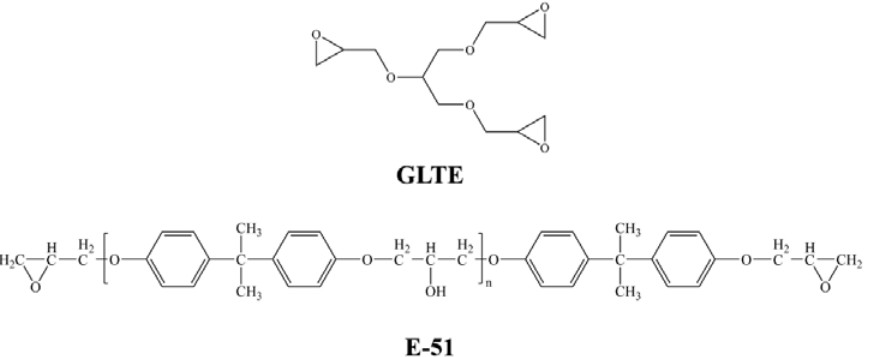
Figure 1. Chemical structures of GLTE and E-51.